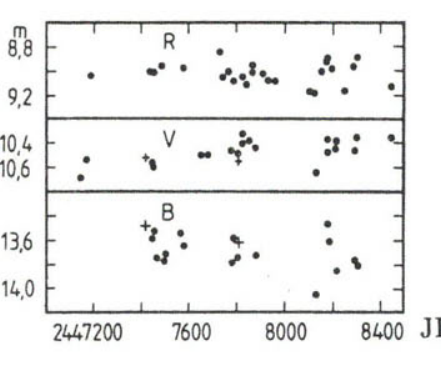
Fig. 2. Λ(0.63)-, V- and J3-magnitudes for EU And versus time in Julian Days. Crosses are photoelectric observations by Kizla (1991).